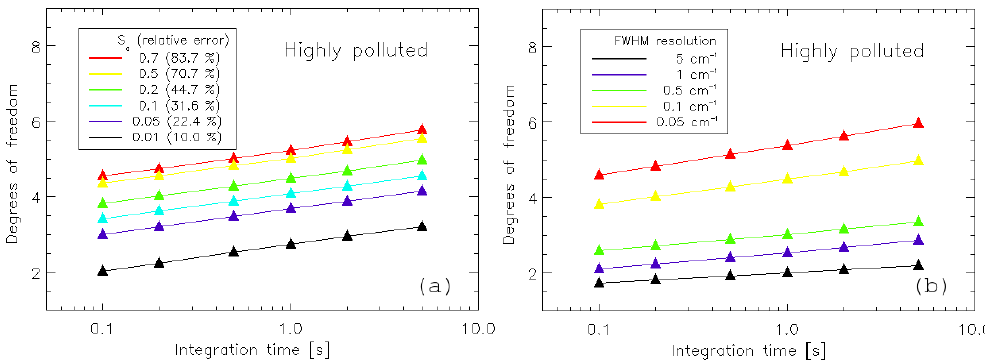
Figure 8. Integration time sensitivity for highly polluted scenario for different S a (a) , and different spectral resolution (b) .